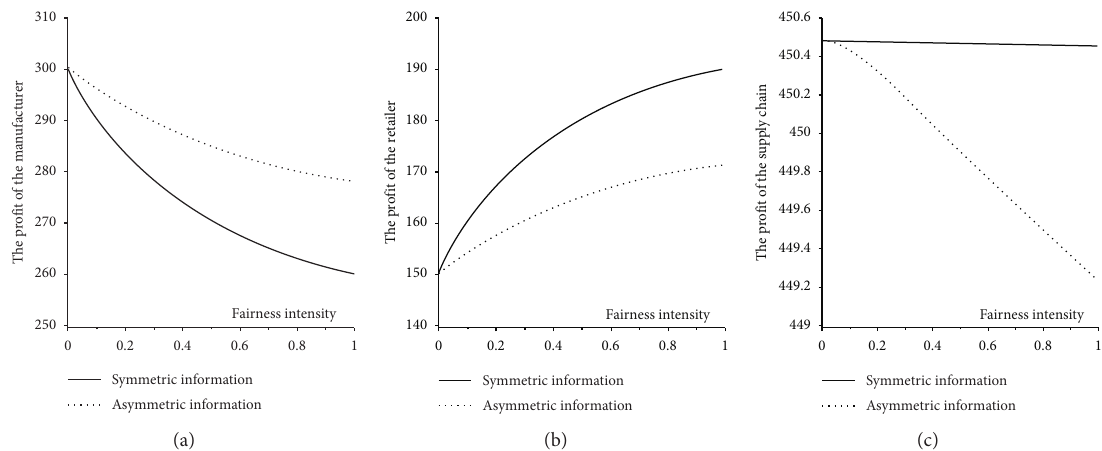
Figure 4: Sensitivity of profitability to fairness concerns. (a) Manufacturer’s profit. (b) Retailer’s profit. (c) Supply chain’s